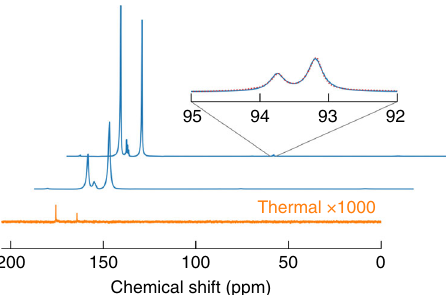
Fig. 3 Two 13 C NMR spectra of hyperpolarized 1- 13 C-pyruvic acid recorded immediately, and two seconds after rapid transfer, dissolution in degassed D 2 O and injection (lower and upper blue curve, respectively). The spectra were recorded with a fl ip angle of ~10°. The spectra show two strongly polarized peaks at 175.7 and 164.2 ppm due to the presence of pyruvate and pyruvate hydrate, respectively. The inset is a close-up of the signal at ~93.5 ppm which is due to the natural abundance carbonyl of pyruvate hydrate. This signal is split into a doublet by the 67 Hz J -coupling to the (labeled) carboxyl carbon. The asymmetry in the doublet is modeled with two Lorentzians (red dotted line) and yields an estimate for the 13 C polarization of 32 ± 1%. The bottom, orange line shows a 1000-fold magni fi cation of the thermal equilibrium signal (4 transients